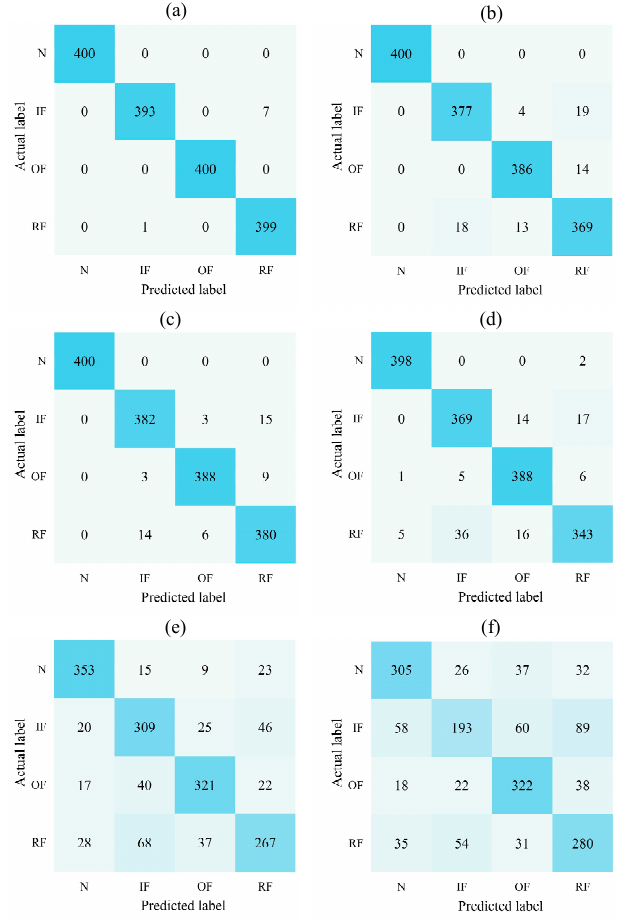
Figure 12. Confusion matrix of the different fault diagnosis methods. ( a ) CBAM–DRN, ( b ) CBAM–CNN, ( c ) DRN, ( d ) CNN, ( e ) SVM, ( f ) BPNN.